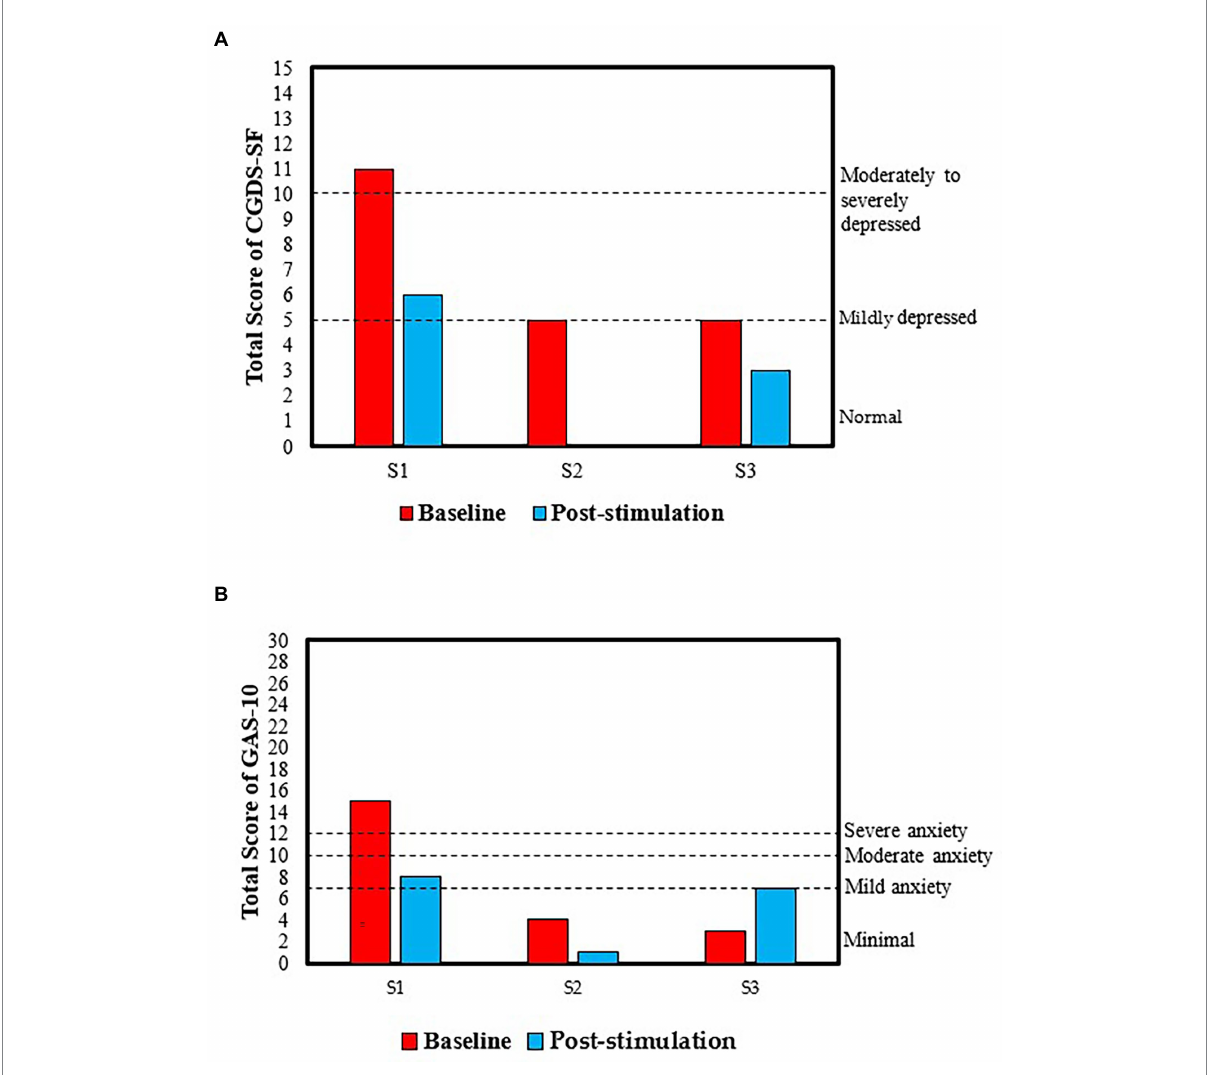
FIGURE 2 Total scores in (A) the Chinese version of the Geriatric Depression Scale—Short Form (CGDS-SF) and (B) the Geriatric Anxiety Scale—10 Item Version (GAS-10) at baseline and after tPBM.